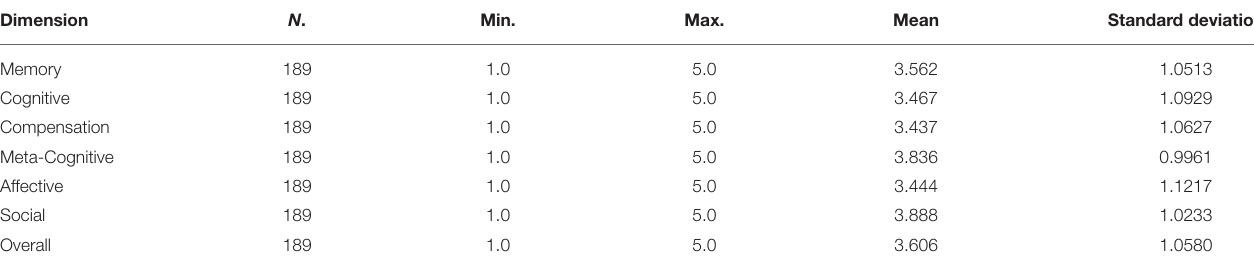
TABLE 2 | Level of strategy use in learning Chinese among the participants. Dimension N .